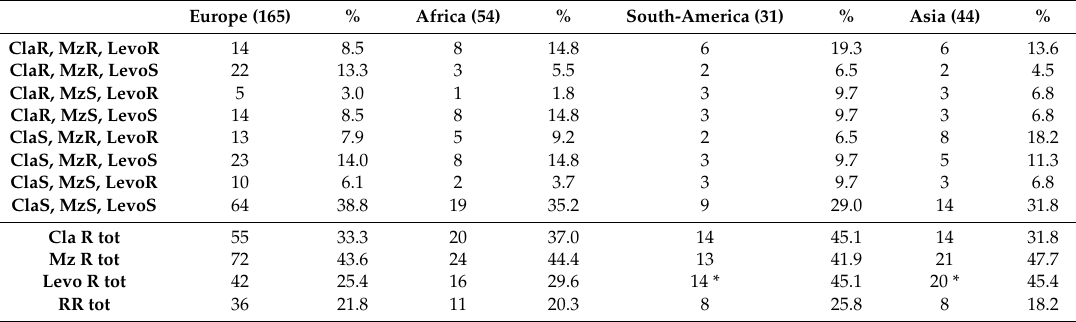
Table 3. Prevalence of antibiotic resistance according to